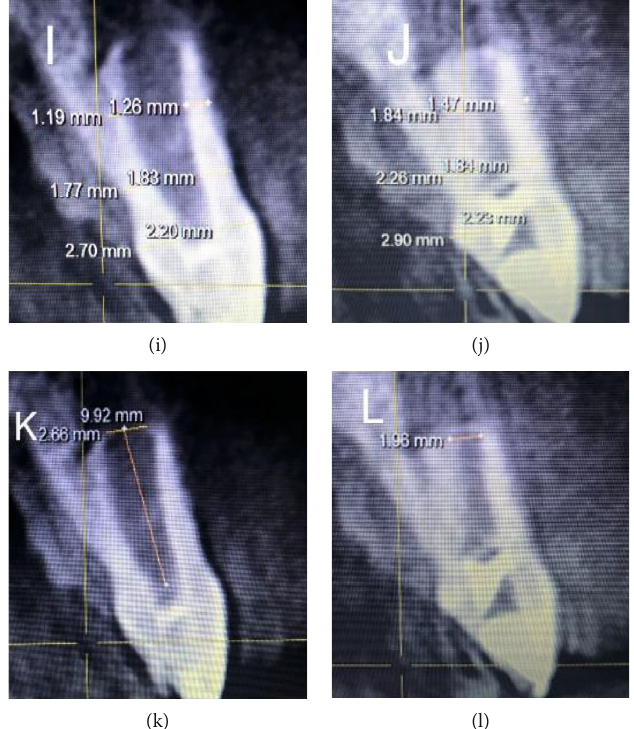
Figure 3: Preoperative clinical, revascularization procedure and radiographic images — IOPA and CBCT images (case report 2). (a) Pre-op clinical photograph showing discoloured and fractured 21 with sinus opening and pus discharge. (b) Preoperative IOPA showing periapical lesion involving the apices of 21 and open apex. (c) Access opening done in 21. (d) Bleeding induced in 21 for revascularization. (e) Placement of CGF in root canal space. (f) MTA plug of 3 mm placed at the level of CEJ in 21. (g) Pre-op CBCT image showing the extent of lesion in sagittal slice. (h) Post-op CBCT image showing the extent of lesion in sagittal slice. (i) Pre-op CBCT showing the root dentin thickness measurement in sagittal slice. (j) Post-op CBCT showing the root dentin thickness measurement in sagittal slice. (k) Pre- op CBCT showing the apical diameter measurement in 21. (l) Post-op CBCT showing the apical diameter in